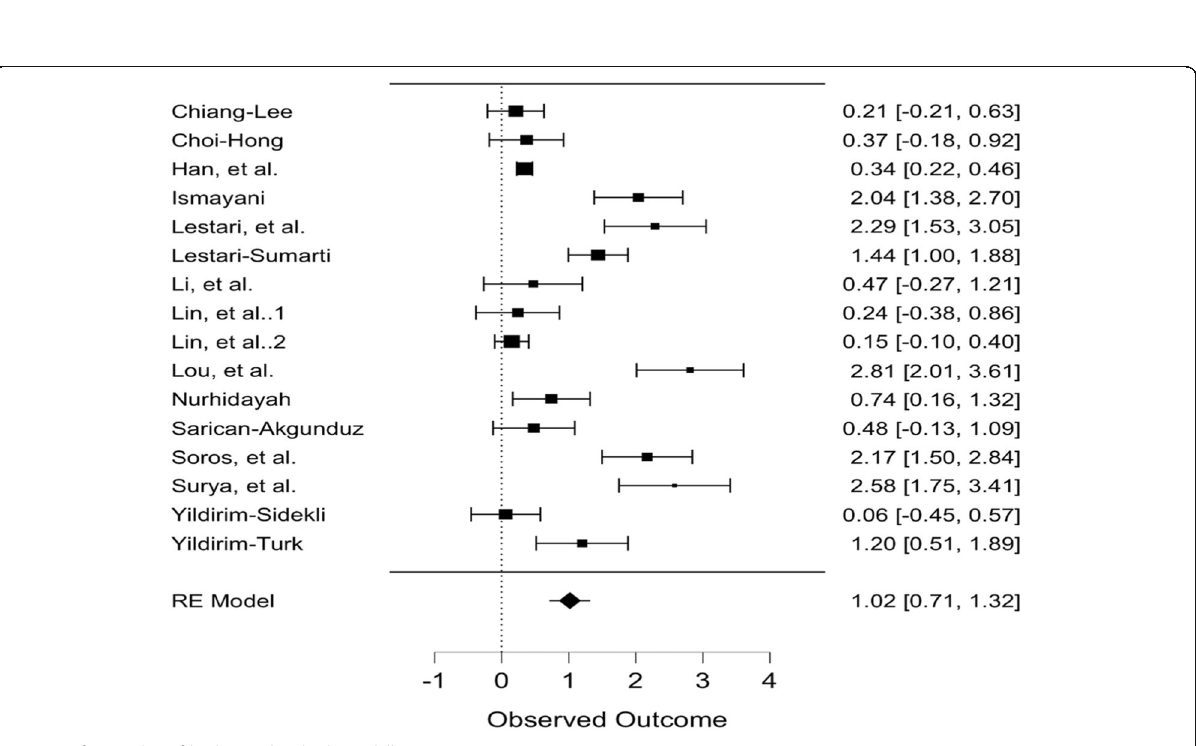
Fig. 3 A forest plot of higher-order thinking skills